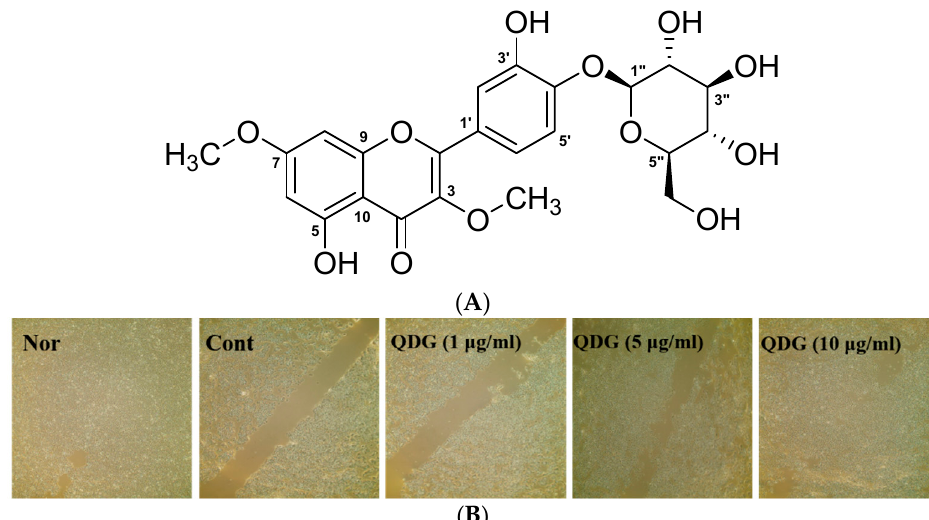
Figure 1. Chemical structure of quercetin 3,7 ‐ dimethyl ether 4 ′‐ glucoside (QDG) ( A ) and increased cell proliferation and migration activities of QDG ‐ treated human keratinocytes (HaCaT) cells ( B ). HaCaT cells were scratched using a yellow tip. Migration levels of HaCaT cells were observed using an optical microscope and photographs were obtained. HaCaT cells were treated with different concentrations of QDG (1, 5, and 10 μ g/mL) for 24 h. QDG treatment leads to an increase in migration of HaCaT cells. Nor: No treatment cell group (0 h), Cont: 20 mJ/cm 2 ultraviolet B (UVB) treatment cell group, QDG: QDG treatment group.